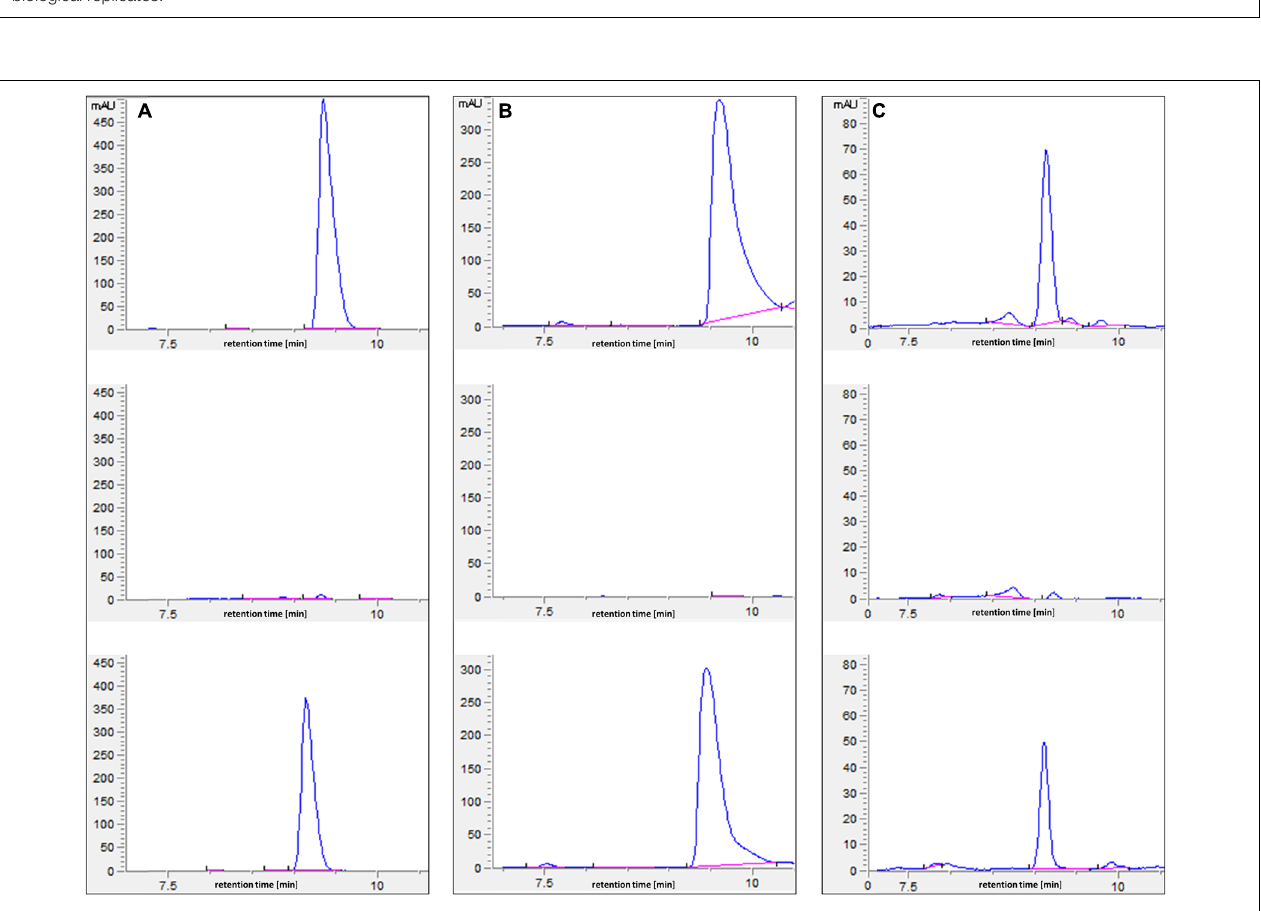
FIGURE 7 | HPLC-based detection of polyamines in supernatant from the 96 h culture of parental strain M145 and (cid:49) glnA3 mutant. Both strains were grown in defined Evans medium supplemented with either (A) putrescine (25 mM), (B) cadaverine (25 mM) or (C) spermidine (25 mM). Upper HPLC chromatogram: polyamine standard, middle HPLC chromatogram: detection of polyamines remained in the supernatant of the M145 culture, lower HPLC chromatogram: detection of polyamines remained in the supernatant of the (cid:49) glnA3 mutant culture. Results indicate that only parental strain S. coelicolor M145 was able to completely utilize whole polyamines from the medium after 96 h of